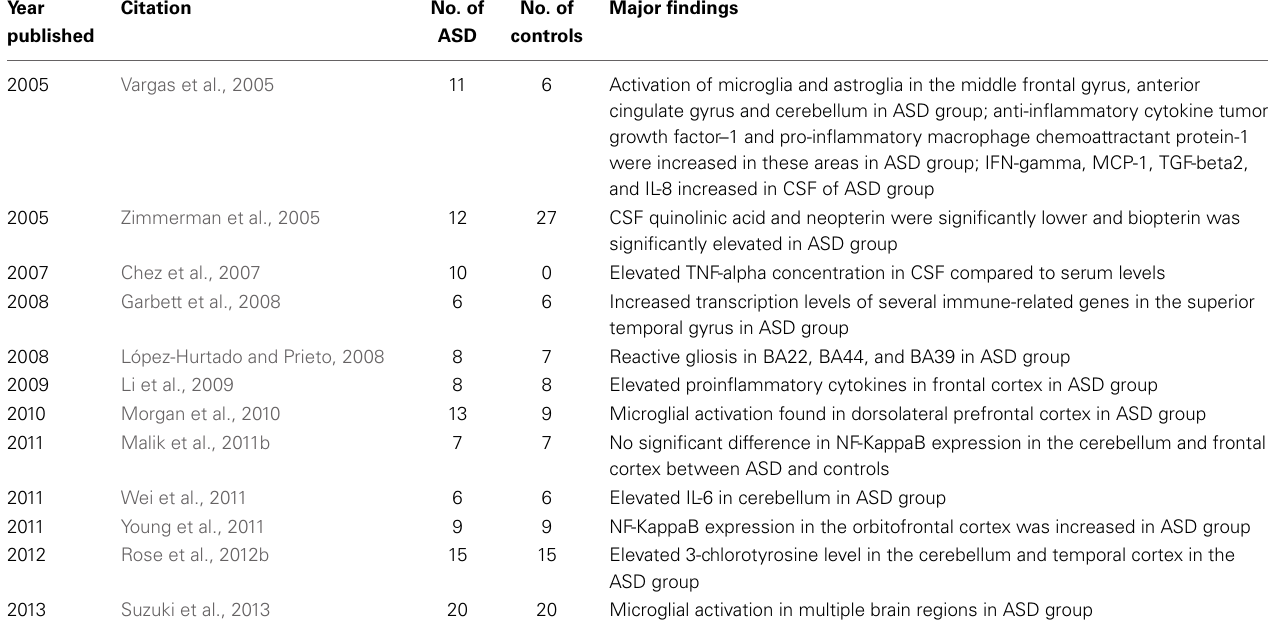
Table 3 | Studies of inflammation/immune dysregulation in the ASD brain.